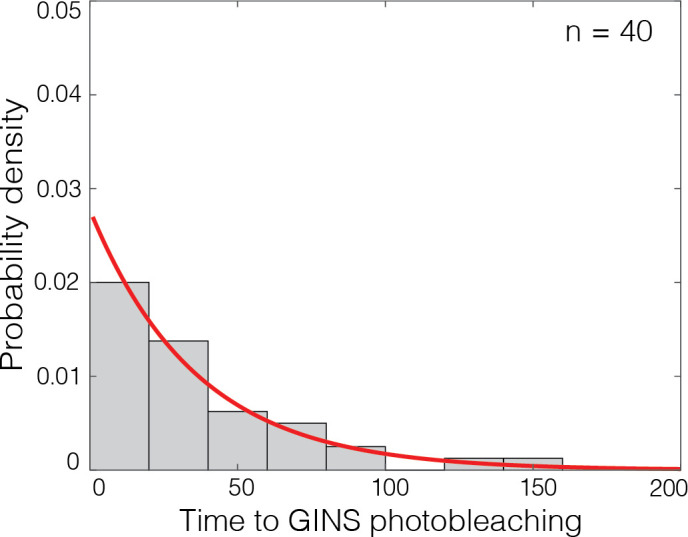
Photobleaching GINSSORT649 events are temporally resolved.Distribution of time intervals until photobleaching for GINSSORT649 bound to DNA with loaded Mcm2-7 prepared at 6.5 nM Dbf4-dependent kinase, as exemplified by the lower-right record in Figure 5B. For records that showed two separate photobleaching steps, the interval was taken to be the time from the first to the second bleaching step. Exponential fit (line) yielded time constant τ = 36 s. This implies that only a small fraction (less than exp (−τ/(3Δt))=1%) of sequential photobleaching steps were mistakenly counted as one rather than two steps, based on the conservative assumption that all steps separated by three or more Δt = 2.6 s video frame intervals were resolved.